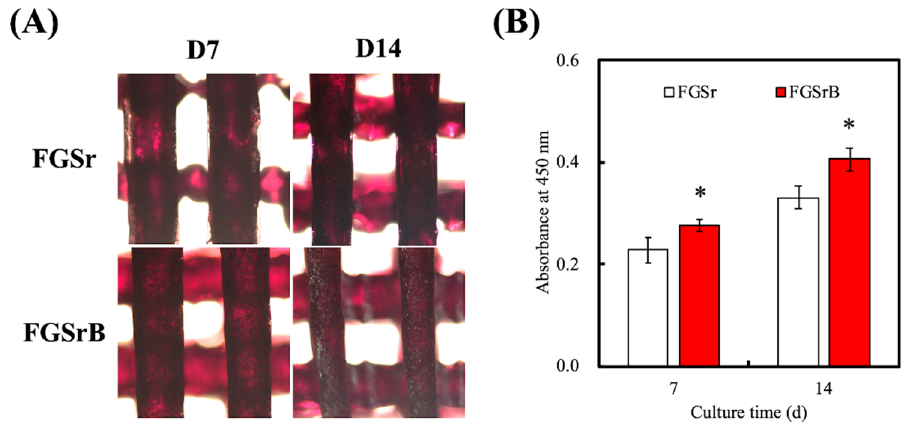
Figure 8. ( A ) Alizarin Red S staining and ( B ) quantification of calcium mineral by WJMSC-laden scaffolds. ‘‘*’’indicates a significant difference ( p < 0.05) when compared to FGSr scaffold. Data presented as mean ± SEM, n = 5 for each group.